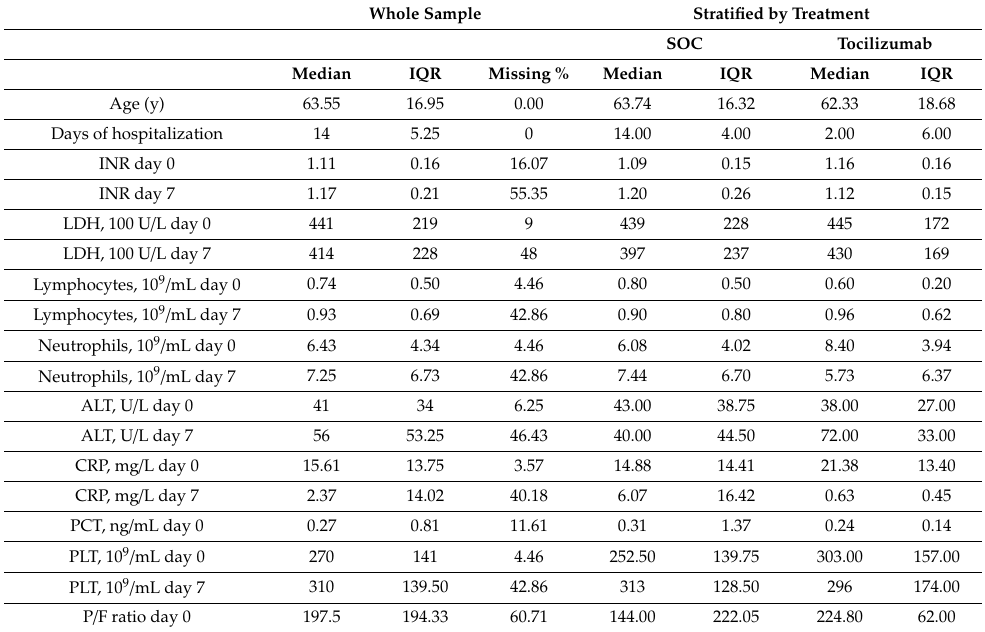
Table 2. Bivariate analysis of laboratory measures in the whole sample and stratified by